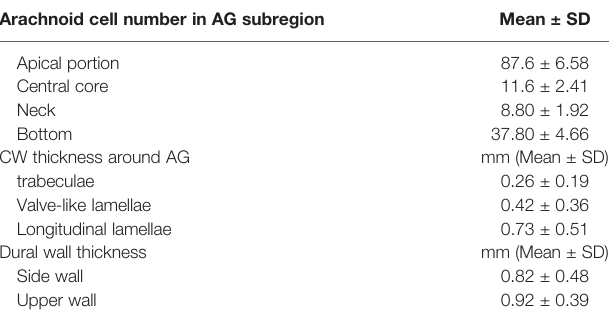
TABLE 1 | Characteristics of AG, CW and dural wall in the superior sagittal sinus. Arachnoid cell number in AG